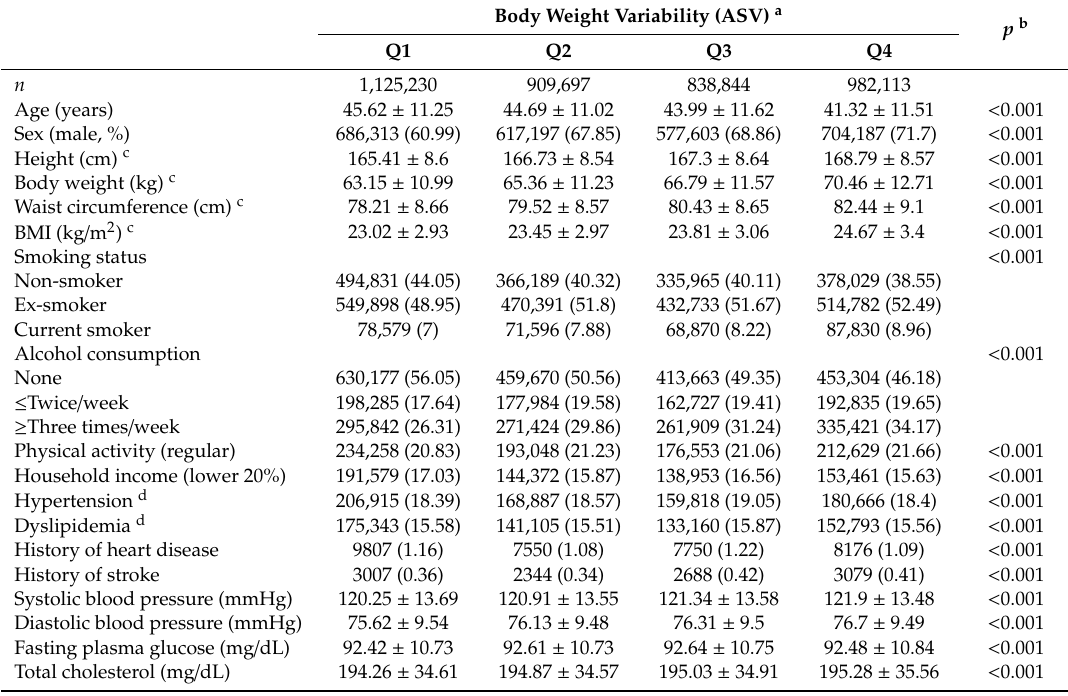
Table 1. Baseline characteristics of the study participants according to the quartiles of body weight